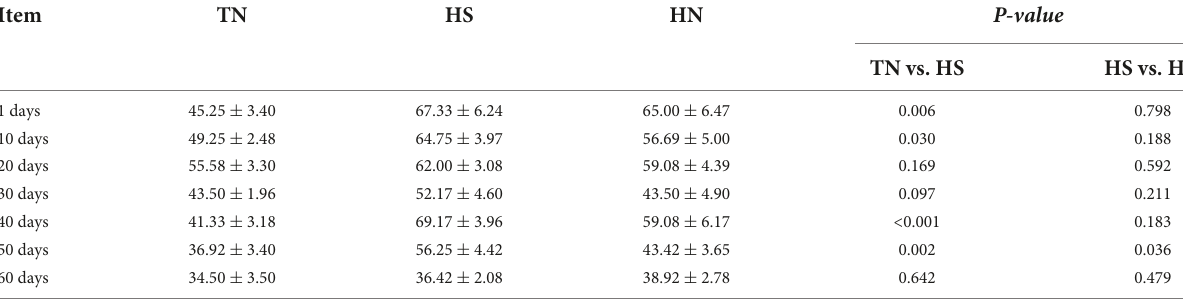
TABLE 3 Effects of niacin on the respiratory rate of beef cattle under heat stress (breaths/min).